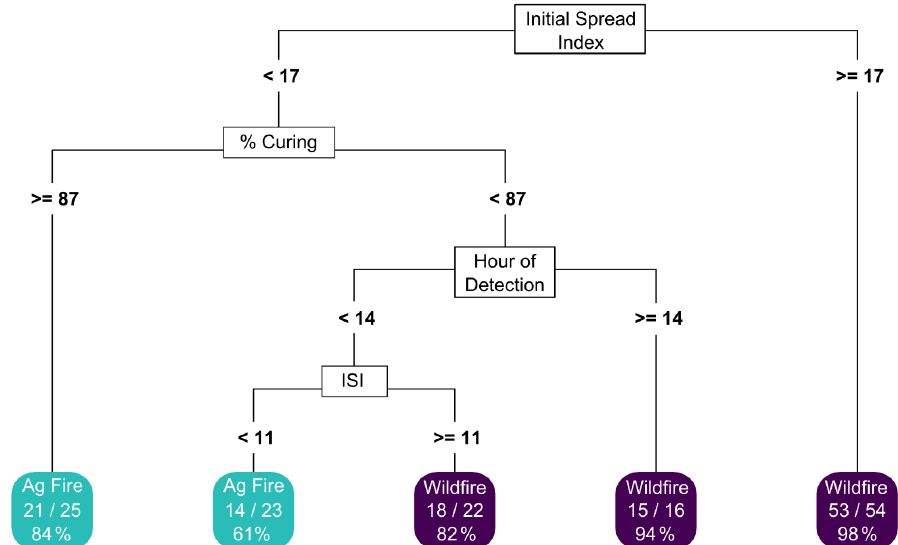
Figure 7. Simple decision tree scheme for the classification of agricultural vs. wildfires. The first set of numbers in each terminal node is the number of correctly classified records divided by the total number of records in that node. The accuracy of each node is also given. Note that high rates of curing are associated with ploughed fields or those previously burned in agricultural fires in the days prior (see Fig. 5).